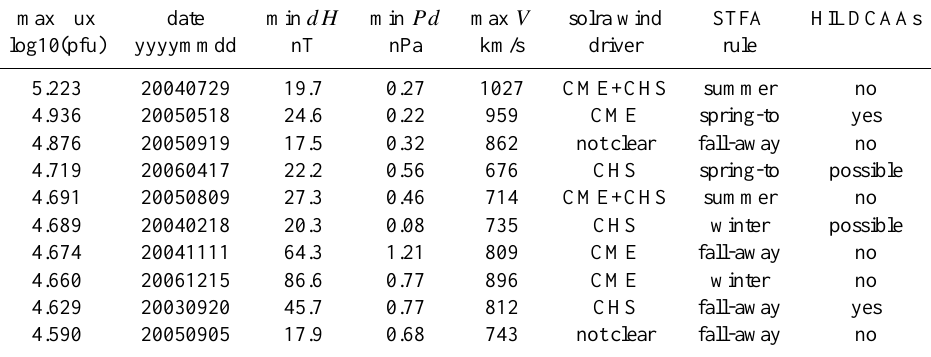
Table 1. Event list of top 10 extreme flux enhancements determined from GOES-8 and 12 observations during solar cycle 23. From left to right, columns show the maximum flux of > 2.0MeV electrons at GEO (pfu=/cm 2 sstr), date of the event, minimum daily variation of H component at GEO in the VDH-coordinate system from t = − 2.0 to 0.0 days, minimum solar wind dynamic pressure, maximum solar wind speed, solar wind driver, the STFA relationship, and HILDCAAs